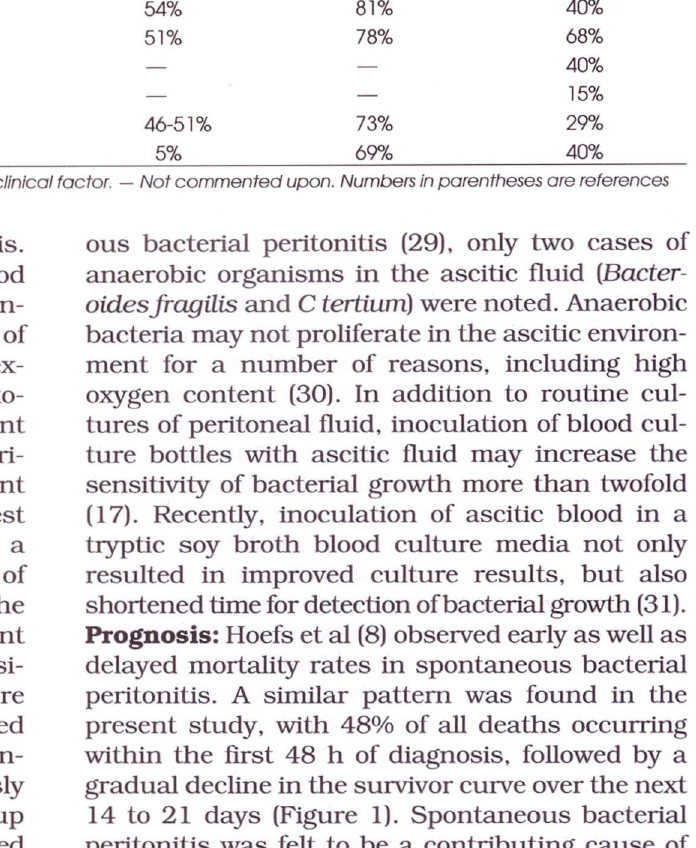
TABLE 3 Comparative analysis of previous reports of clinical signs and symptoms of spontaneous bacterial peritonitis Rimland and Hand